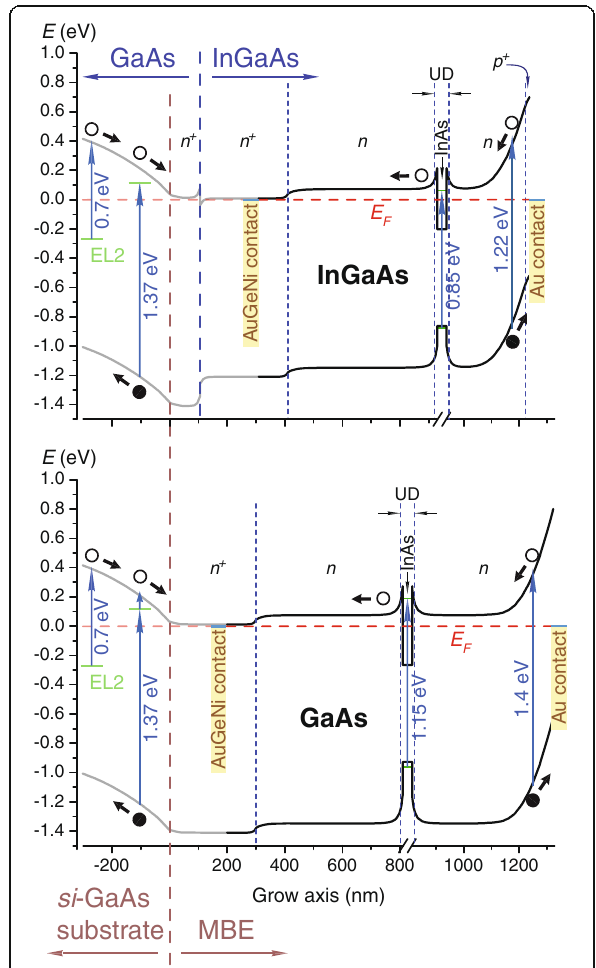
Fig. 3 (Color online) calculated band profile in the metamorphic InAs/ In 0.15 Ga 0.85 As (up) and pseudomorphic InAs/GaAs (down) structures, to explain the PV mechanism. The band bending of the deeper layers beneath the AuGeNi contact is indicated in gray. The optical transitions observed in the PV spectra are indicated by vertical arrows; bold arrows show drift directions of the optically excited charge carriers under the internal field (PV creation); E F is Fermi energy. The calculations were carried out using Tibercad software